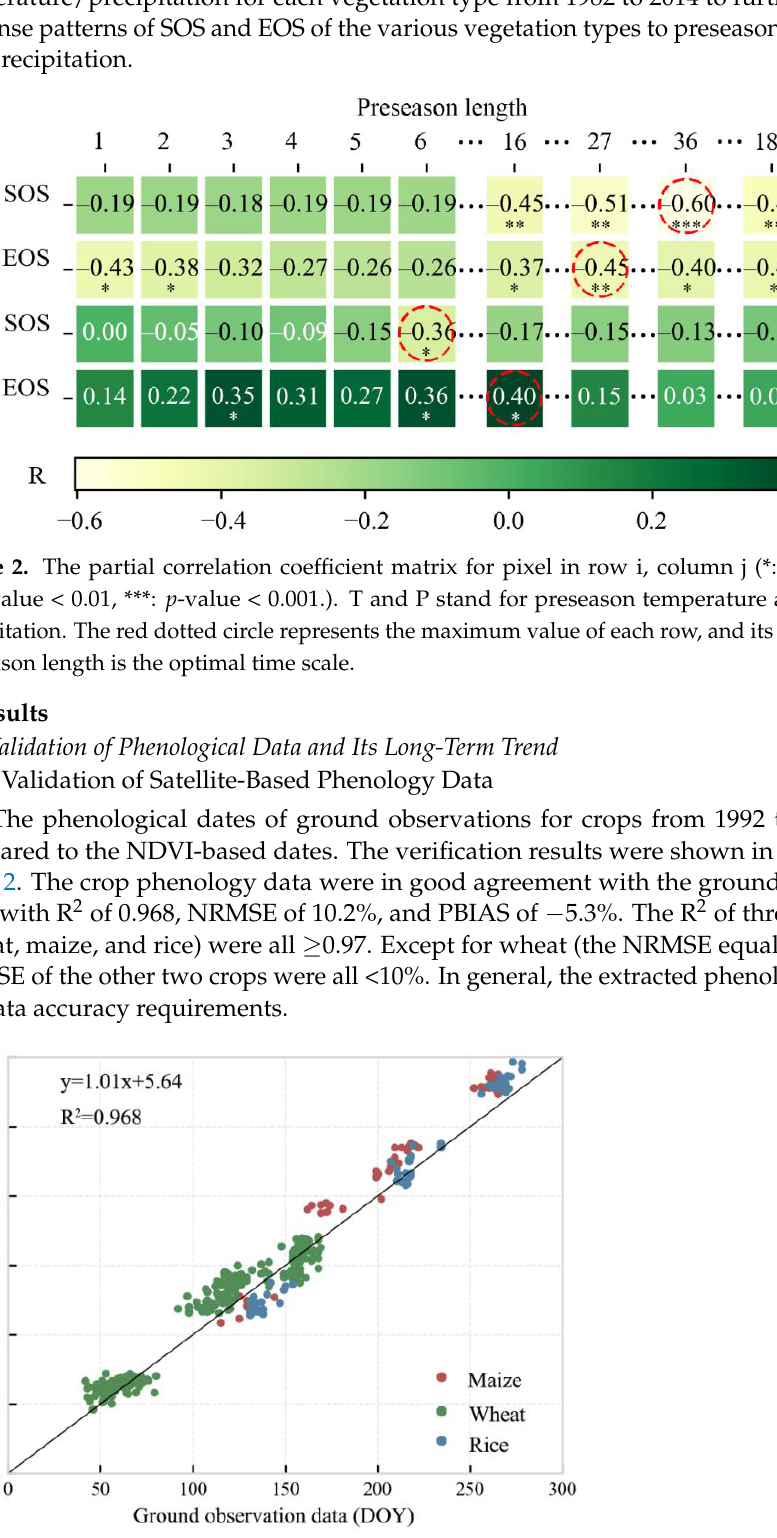
Figure 3. Comparison and verification of extracted phenological data and ground observation data for crops. Table 2. Validation parameters of retrieved phenological data.